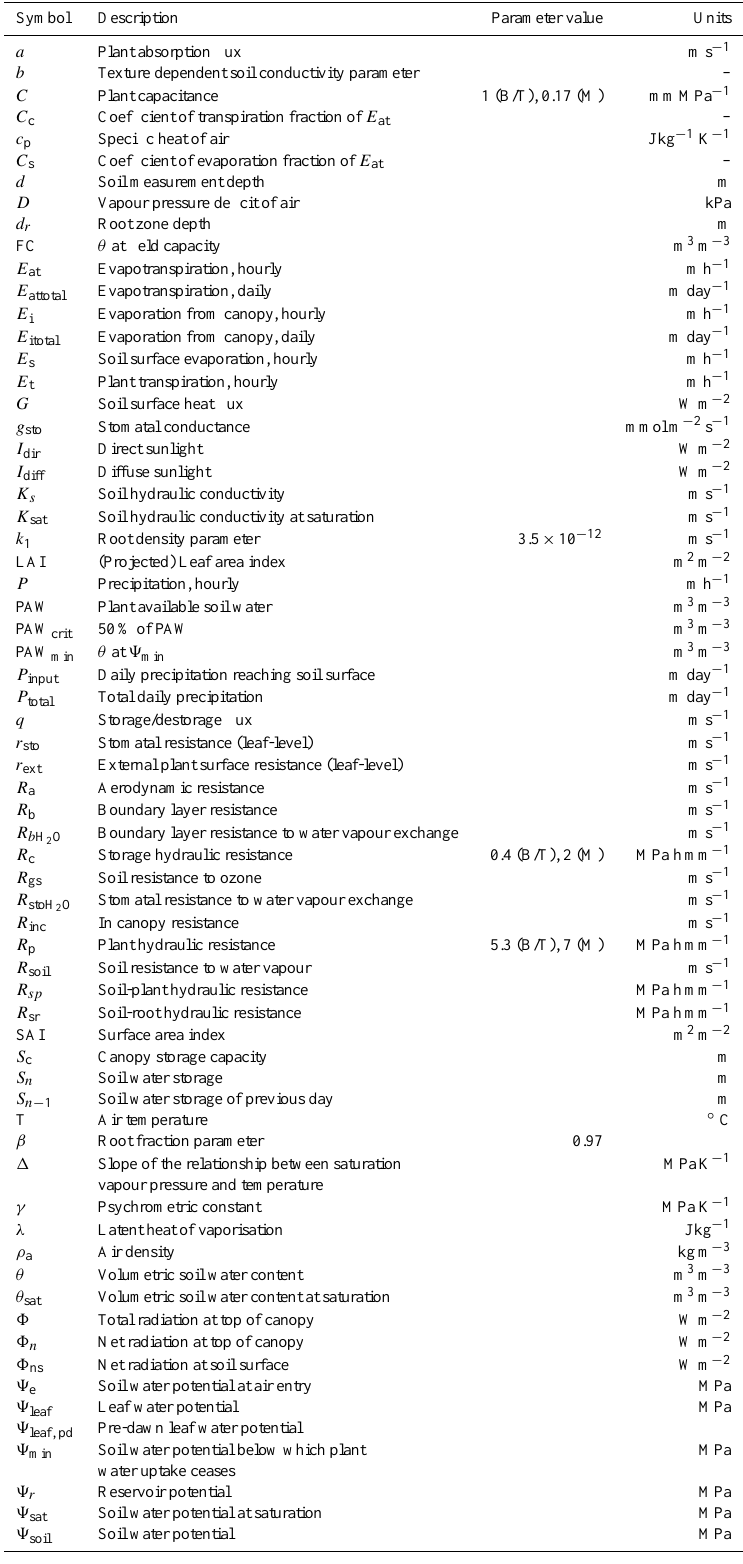
Table 1. Symbols, abbreviations and parameter values.